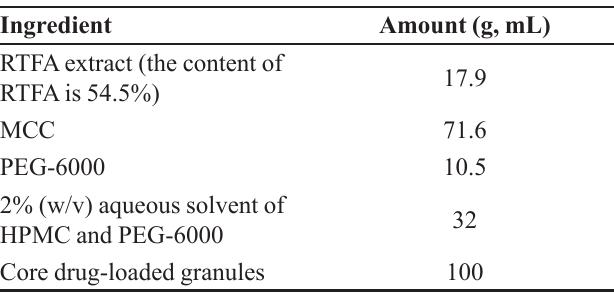
TABLE I - The formulation of core drug-loaded granules